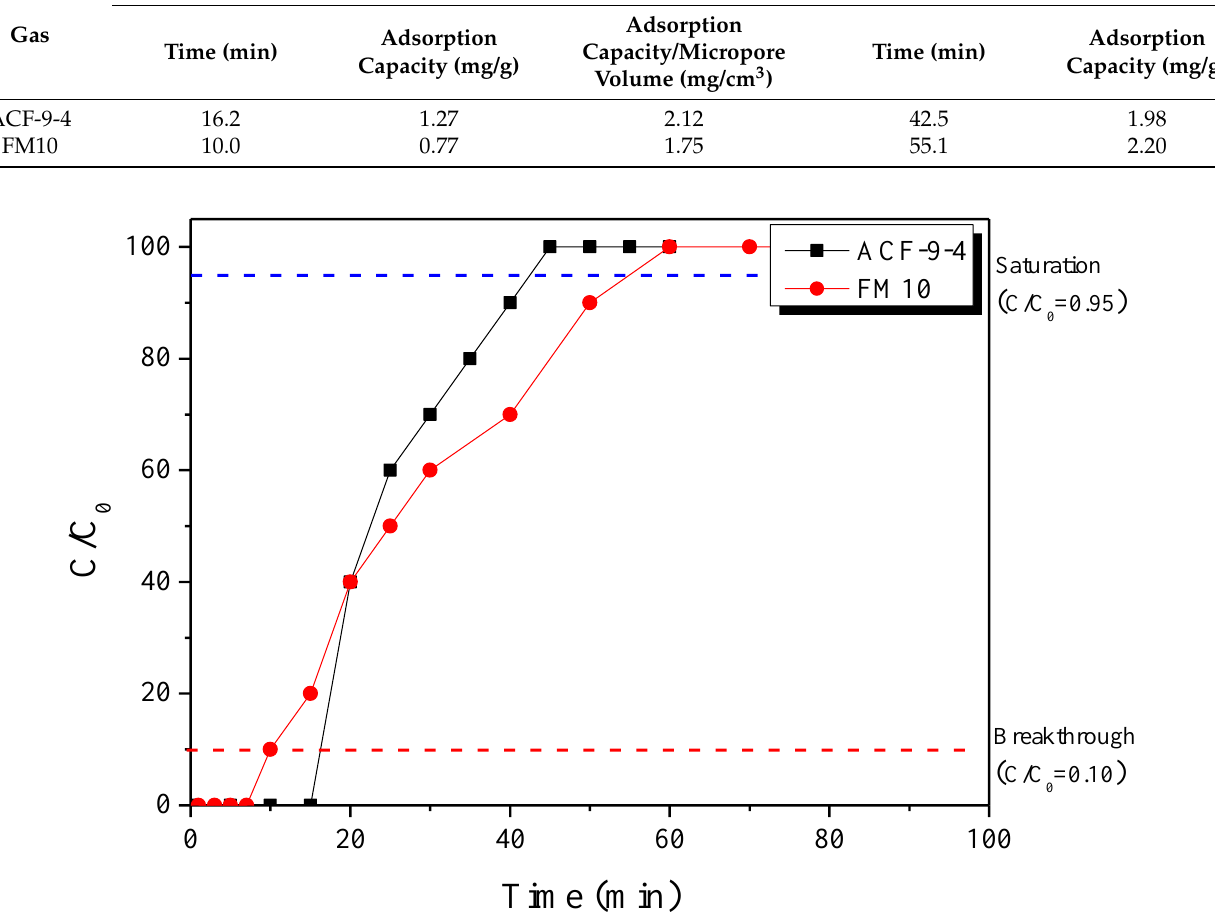
Saturation Saturation